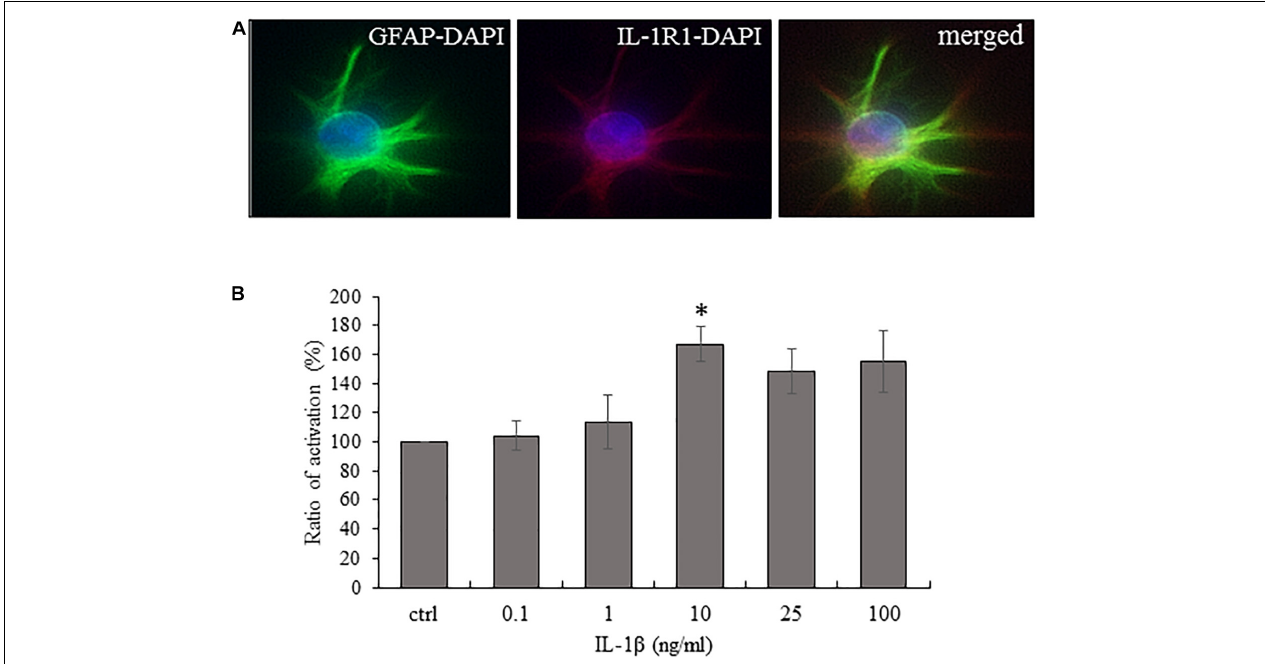
FIGURE 2 | Cultured spinal astrocytes express IL-1R1 and their activity is significantly increased upon IL-1 β stimulation. (A) Cultured spinal astrocytes express the ligand binding unit or IL-1 receptor (IL-1R1). Micrographs of fluorescent images illustrating co-localization between GFAP astrocytic marker (a,c; green) and IL-1R1 (b,c; red). Panel a–c represent control cultures. Mixed colors (yellow) on the superimposed image (c) indicate double labeled structures. On all images DAPI was used to label cell nuclei (blue). (B) Dose-dependent (1–100 ng/ml) enhancement of astrocytic activity by IL-1 β was determined by MTT assay after 24 h of treatment. Quantification of MTT activity is presented as fold change over the control cells in percentage. Data are shown as mean ± SEM of three independent experiments in duplicate assay (ANOVA Repeated Measures, followed by Tukey’s pairwise comparison ∗ p < 0.05 versus control group).